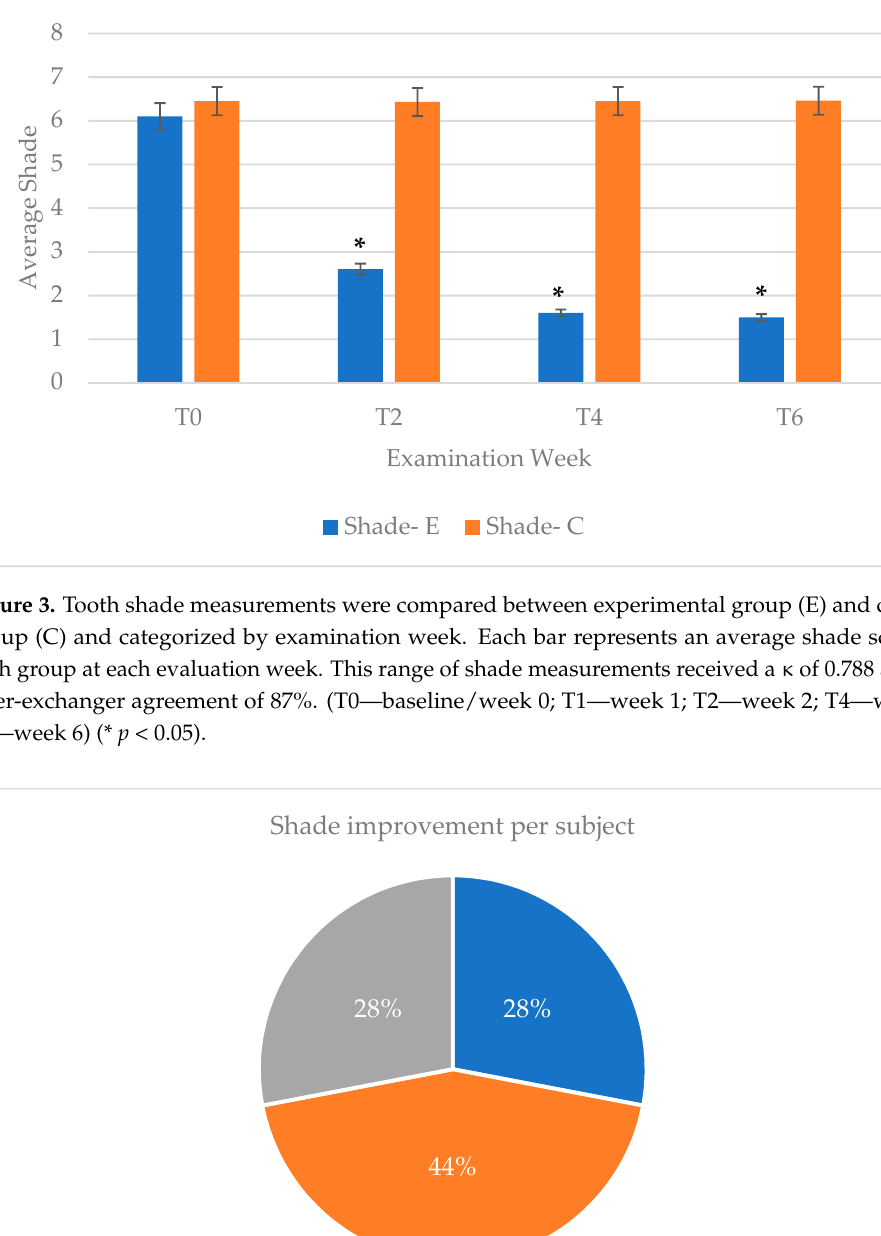
Figure 4. After four weeks of using 10% CP, the subjects experienced variable ranges of shade improvement where 28% improved by 1–2 shades, 44% improved 3–6 shades, and 28% improved by 7+ shades.